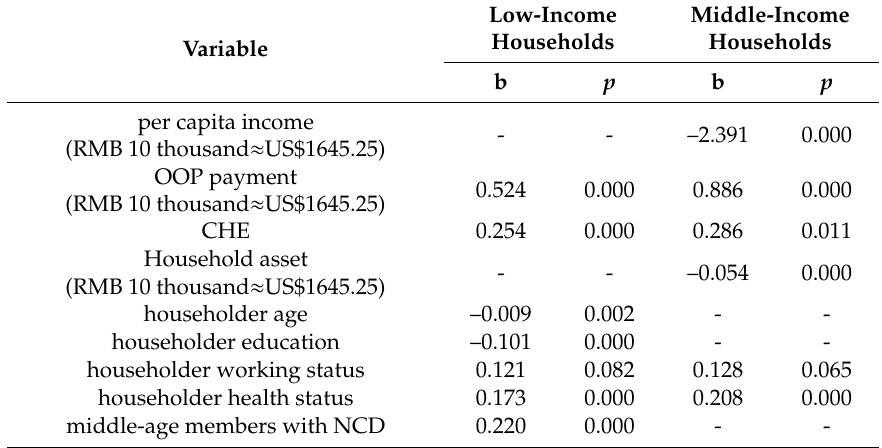
Table 4. Tobit Regression Model of Influencing Factors on Medical Debt of Low- and Middle-Income